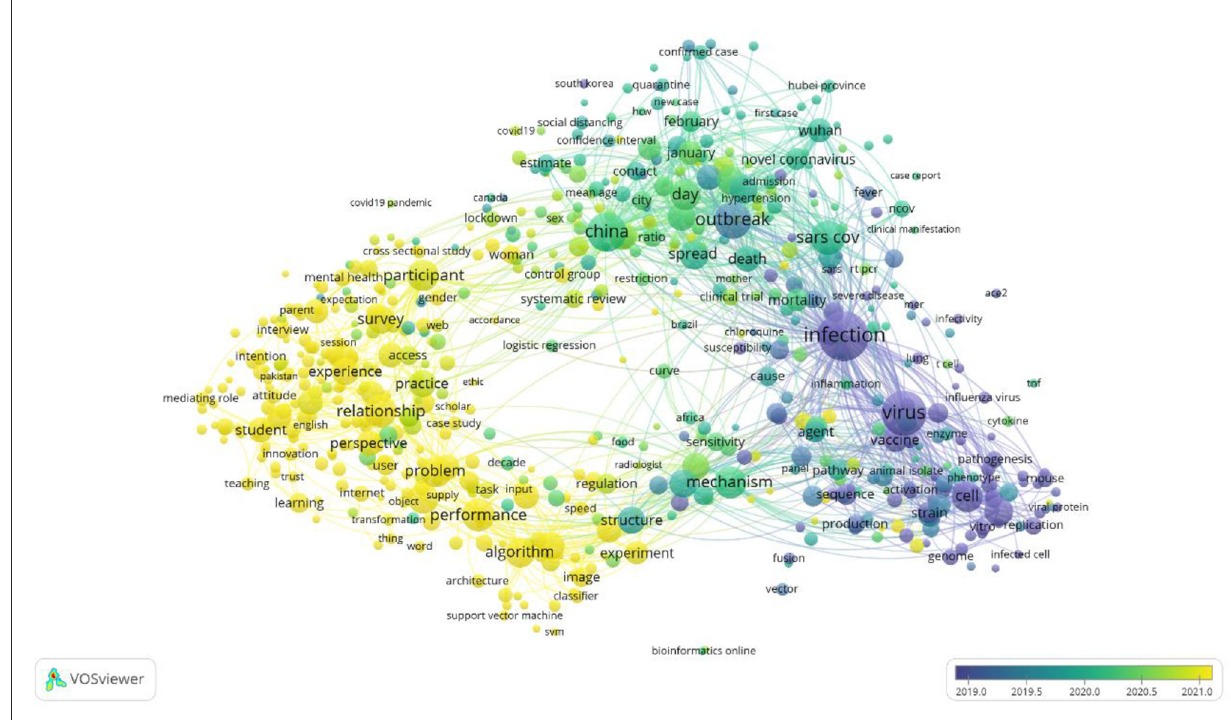
FIGURE4 Overley visualization of the articles based on publication